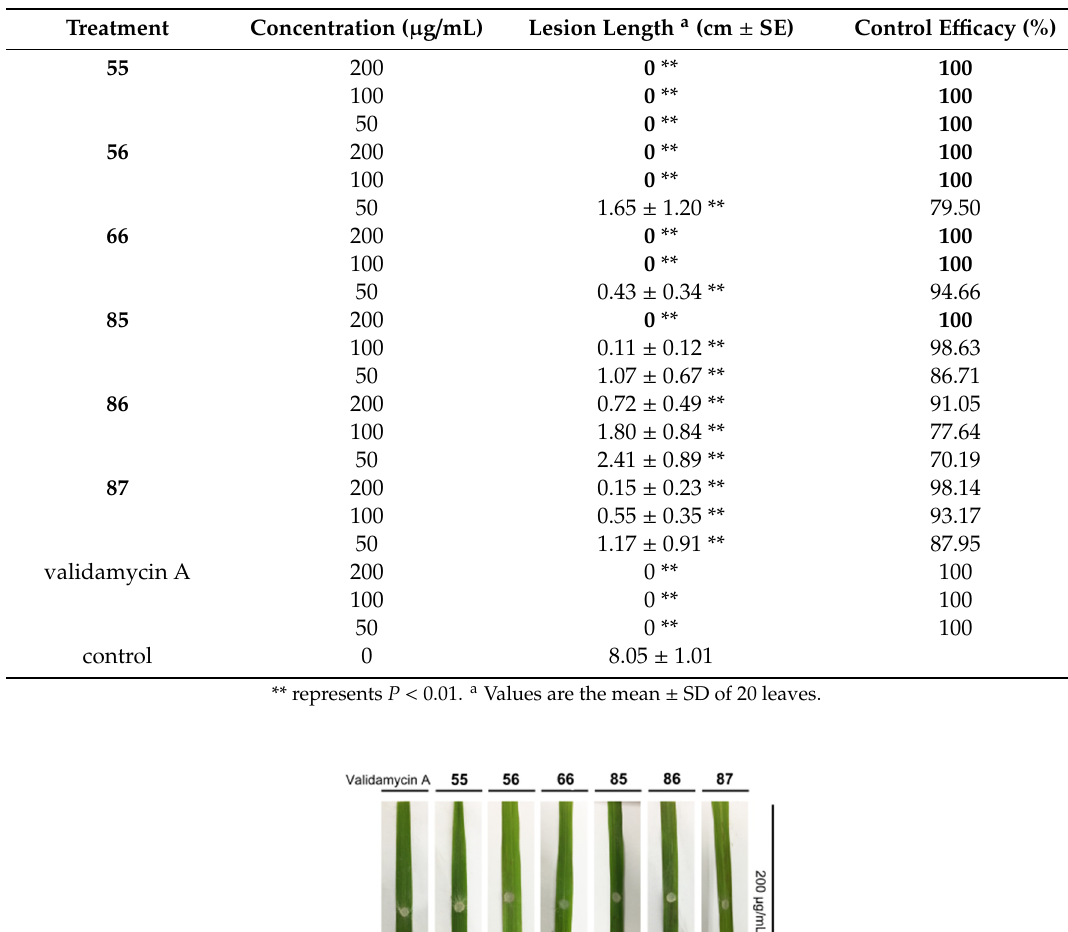
Table 6. In vivo protective and curative effects against R. solani using greenhouse experiment. Treatment